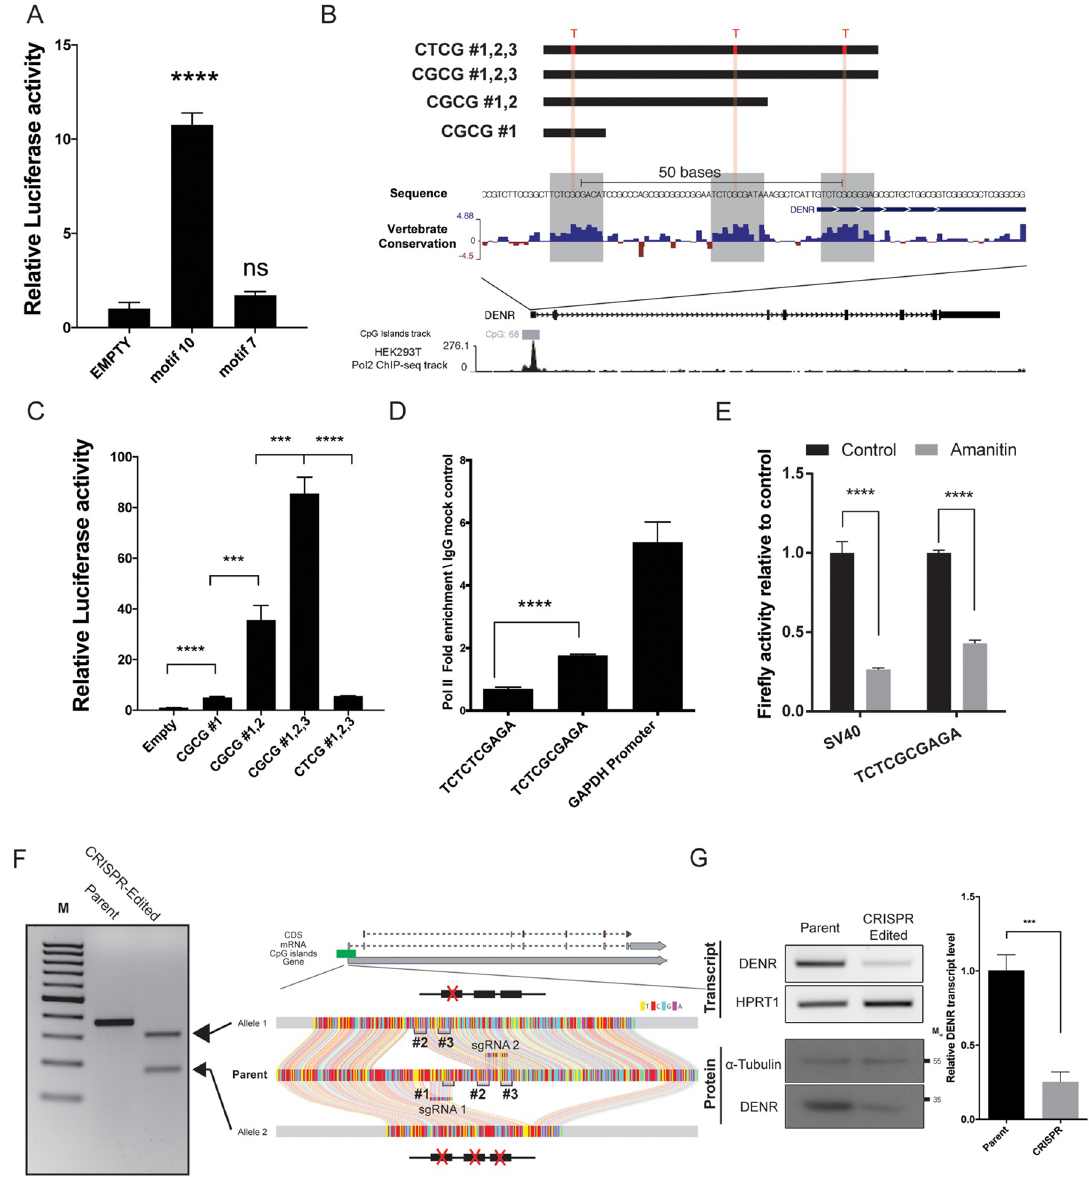
Fig 2. CGCG elements recruit RNA polymerase 2 and activate reporter expression. A) Firefly reporter activity driven by motif 7 and 10. B) The structure and sequence of the human DENR promoter and promoter fragments used for reporter studies. Note that the sequence selected from this promoter do not contain a known core promoter element. The DENR promoter contains three highly conserved copies of the CGCG element. ENCODE Pol II ChIP-seq data from HEK293T cells (bottom) demarcates Pol II occupancy in the promoter region. C) Reporter activity of the corresponding DENR fragments as described in section b. D) Pol II-ChIP on chromatin from HEK293T cells transfected with reporter constructs driven by the wild-type (TCTCGCGAGA) or mutant (TCTCTCGAGA) CGCG motifs, using the human GAPDH promoter as a positive control. E) The effect of α -amanitin on TCTCGCGAGA-driven firefly reporter expression. α -amanitin significantly reduced both SV40 and CGCG-driven reporter expression. F) CRISPR/Cas9 double- nickase strategy was employed to target CGCG elements in the endogenous DENR promoter. The agarose gel image on the left side of this panel shows genomic PCR amplification products of the DENR promoter in parental and CRISPR-edited cells. Two shorter PCR products associated with CRISPR-edited clone indicate deletions in different alleles. Ribbon plots reveal Sanger sequences of parental and edited alleles shown in the gel image. G) qRT-PCR (“Transcript”) and immunoblot (“Protein”) analyses of DENR expression from the parental and edited cell lines, with the data from three replicate qRT-PCR experiments quantified at right (+/-